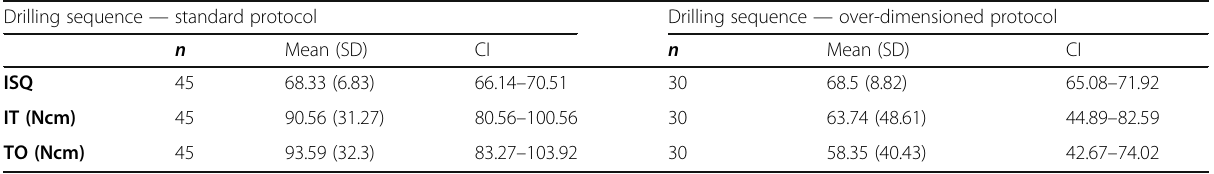
Table 1 Comparison of standard and over-dimensioned protocol Drilling sequence — standard protocol Drilling sequence — over-dimensioned protocol